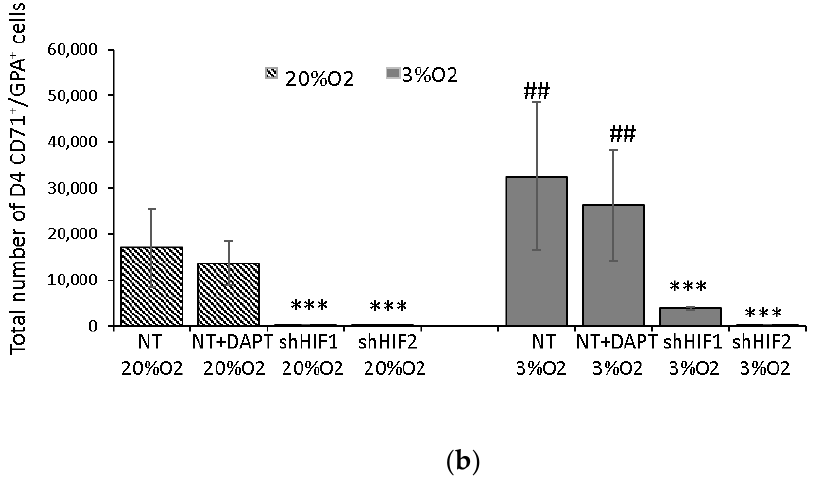
Figure 4. Erythroid differentiation. ( a ) Glycophorin A (GPA) and Transferrin receptor expression on erythroid cells obtained at Day 4 and Day 8 of culture of non-transduced CD34 + cells in presence or absence of Notch γ -secretase inhibitor DAPT as well as transduced CD34 + cells with shHIF1α or with shHIF2α at 20 and 3% O 2 . The bars show the average percentage of GPA + /CD71 + cells. ( b ) The average value of total number of GPA + /CD71 + cells in 4-day culture. Data are presented as mean ± SD of seven independent experiments. The asterisks indicate a significant difference with respect to NT condition at p < 0.05 (*), p < 0.001 (***); the hashtags indicate a significant difference with respect to 20% O 2 condition at p < 0.01 (##), Mann–Whitney test. NT, non-transduced CD34 + cells; D, day of